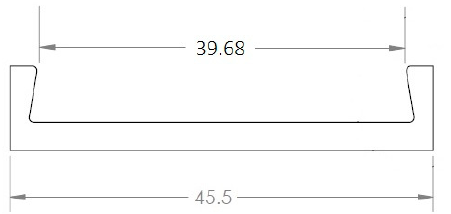
Figure 26. U ‐ shaped sacrificial steel specimen dimensions.